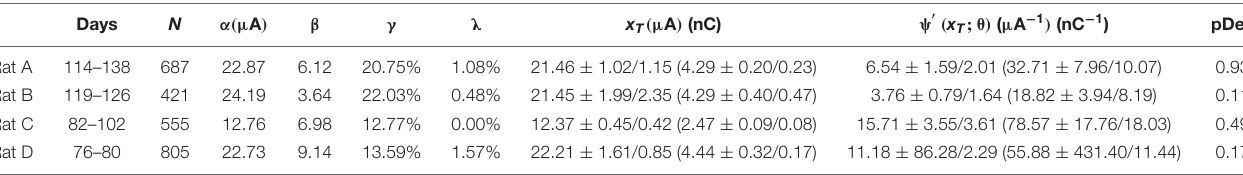
FIGURE 6 | (A–D) Psychometric curves for Rats A, B, C, and D stimulated with the multi-channel configuration, in which equal currents passed through all eight channels simultaneously. Reported stimulus amplitudes correspond to currents passed through each individual channel, and not the total current. Error bars represent 95% confidence intervals for binomial distributions based on detection probabilities. See Table 2 for fitted parameters, 50% detection thresholds, slopes, and goodness of fit metrics. (E,F) Collated 50% detection thresholds ( x T ) and slopes ( ψ (cid:48) ( x T ) ) extracted from the preceding four psychometric curves. Horizontal dotted lines represent the mean values across all rats. Error bars represent 95% BC a confidence intervals. TABLE 2 | Fitted parameters α , β , γ and λ for the four psychometric curves generated by multi-channel stimulation of Rats A, B, C, and D (see Figure 6